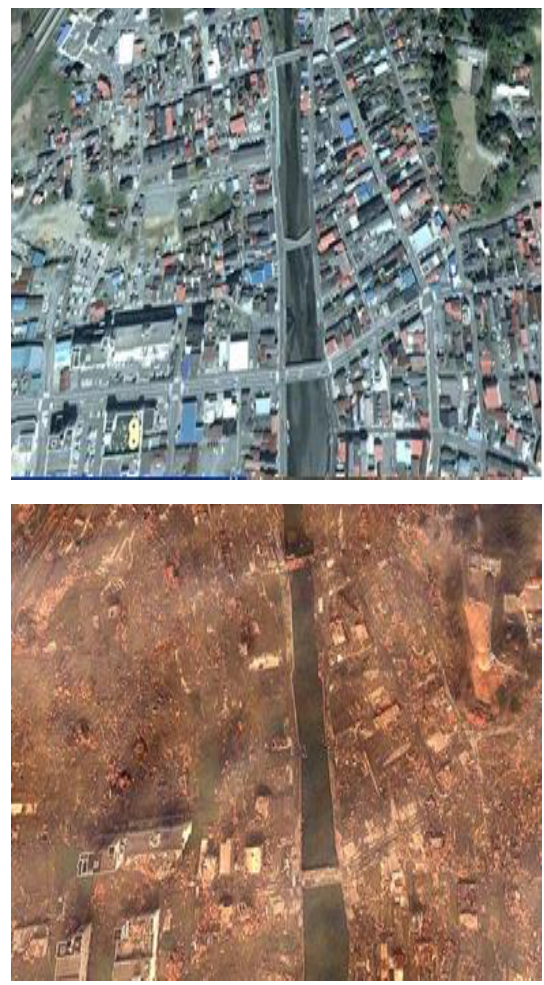
Fig 4 : Pre and Post tsunami